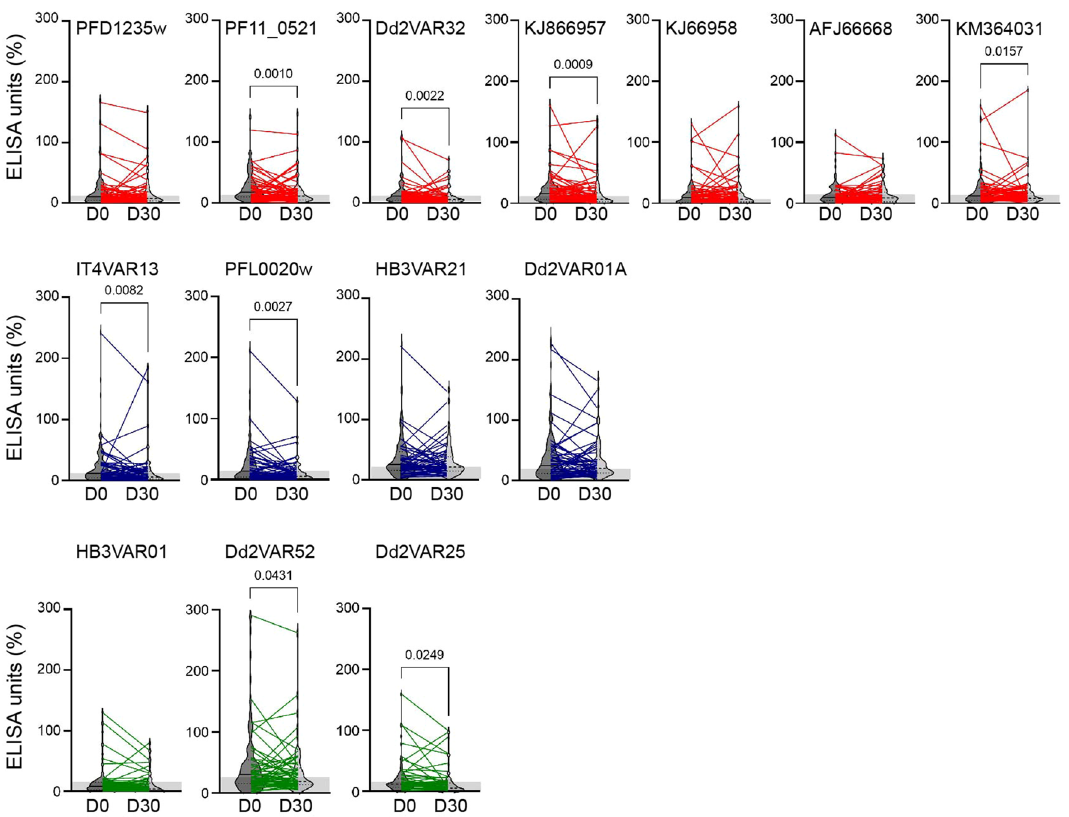
Figure 1. Plasma levels of IgG with specificity for P. falciparum DBLβ domains. Samples were obtained from 137 Beninese children at hospitalization (day 0) and at convalescence (day 30) following discharge from the hospital. Antibody levels (ELISA units; EU) in plasma from individual children against the ICAM-1-binding DBLβ of group A (top panel) PFD1235w, PF11_0521; Dd2VAR32, KJ866957, KJ866958, AFJ66668, KM364031, ICAM-1-binding group B (middle panel) IT4VAR13, PFL0020w, HB3VAR21, Dd2VAR01A, and non-ICAM-1- binding group A (bottom panel) DBLβ domains of HB3VAR01, Dd2VAR52, and Dd2VAR25. The violin plots show the median and interquartile range of all-day 0 and day 30 samples, lines show day 0 and day 30 values of paired samples i.e., same individual. Statistical significance comparing day 0 and day 30 was determined using Wilcoxon matched pairs signed rank test and significant P- values shown along the top of the panels. Thirty (30) non-exposed Danish individuals were included as negative controls (DK); the grey shaded area indicates sample reactivity below the cut-off (DK mean +